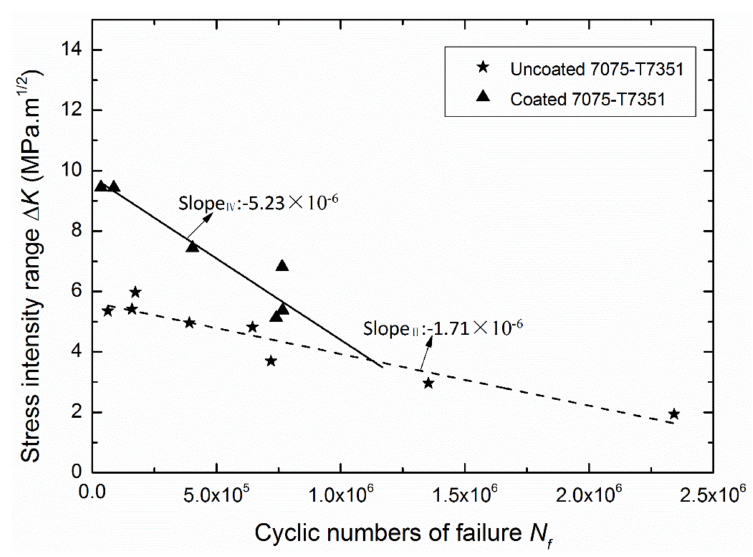
Figure 5. Relationship between ∆ K and cyclic numbers of failure in 5.0% NaCl for uncoated and coated 7075-T7351 Al